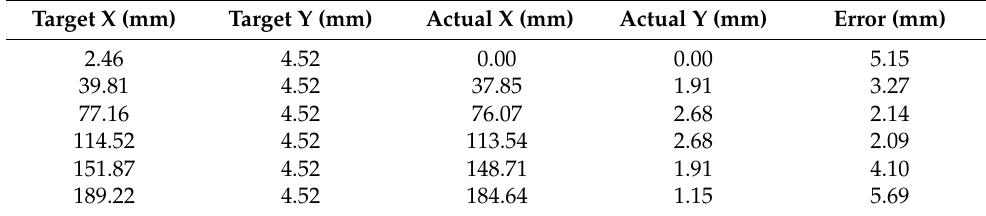
Table A3. Run 2 positional data (lower half of the